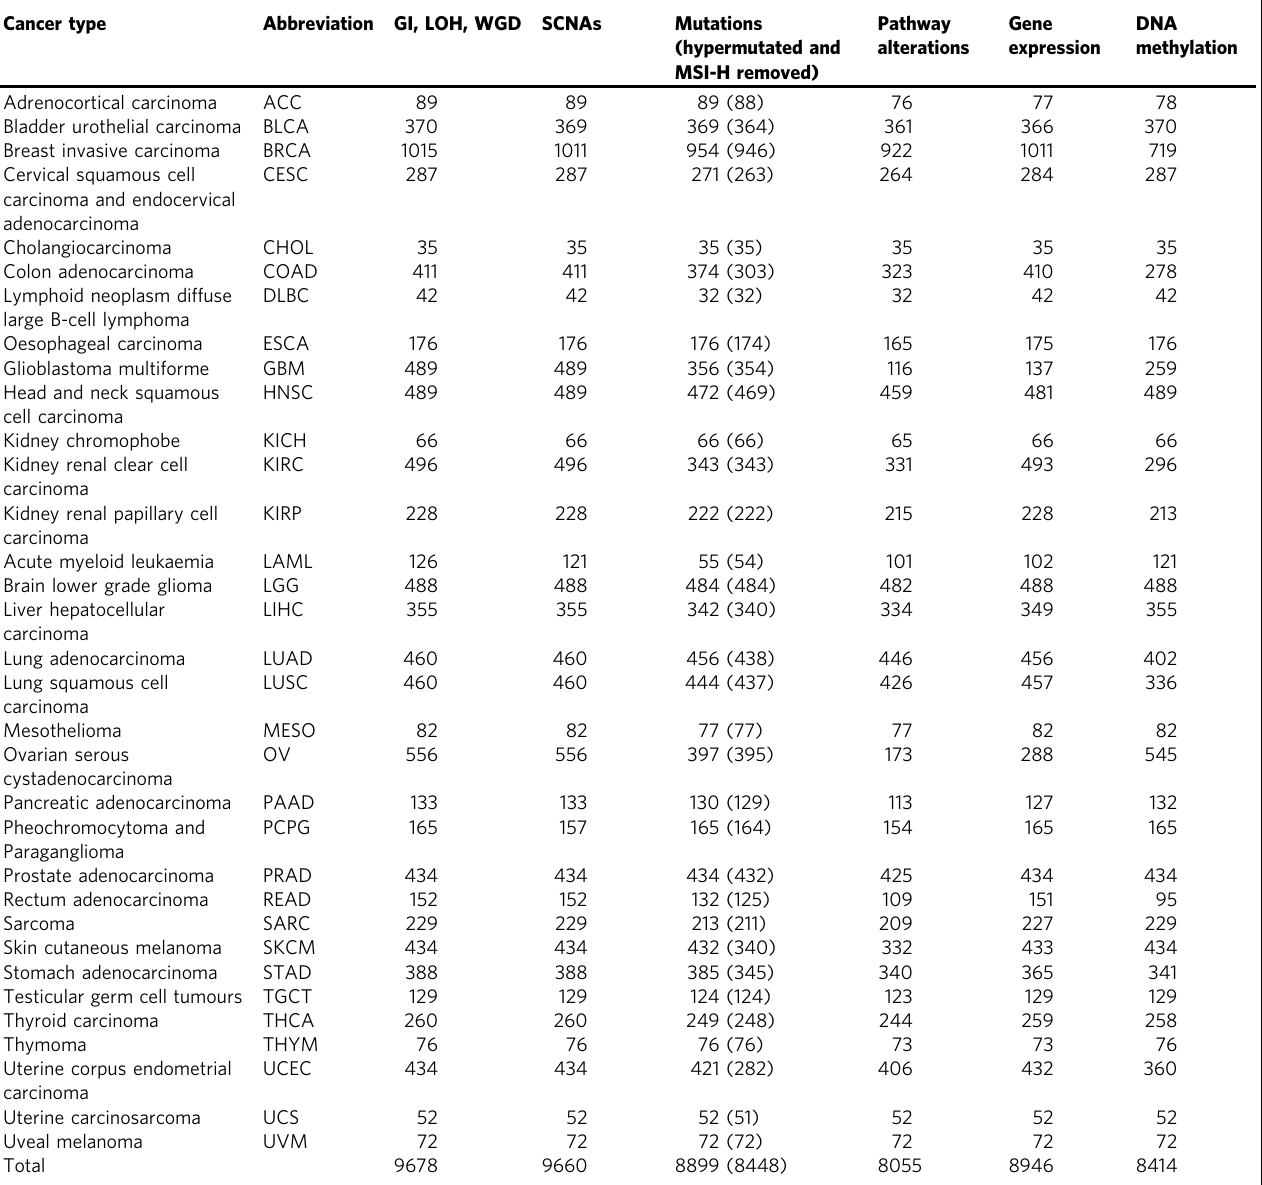
Table 1 Summary of TCGA cancer type and number of samples used in each analysis. Cancer type Abbreviation GI, LOH, WGD SCNAs Mutations